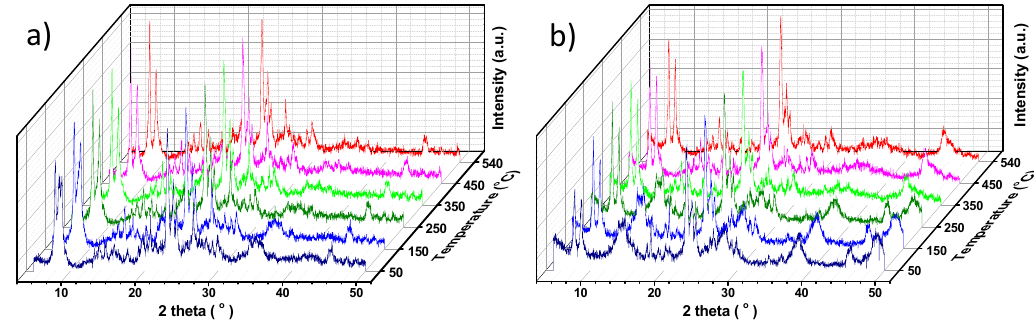
Figure 3. In situ XRD patterns of HZ-atp ( a ) and HZ-bo ( b ); in situ scanning at 100 °C steps from 50 o C to 540 °C under synthetic air.